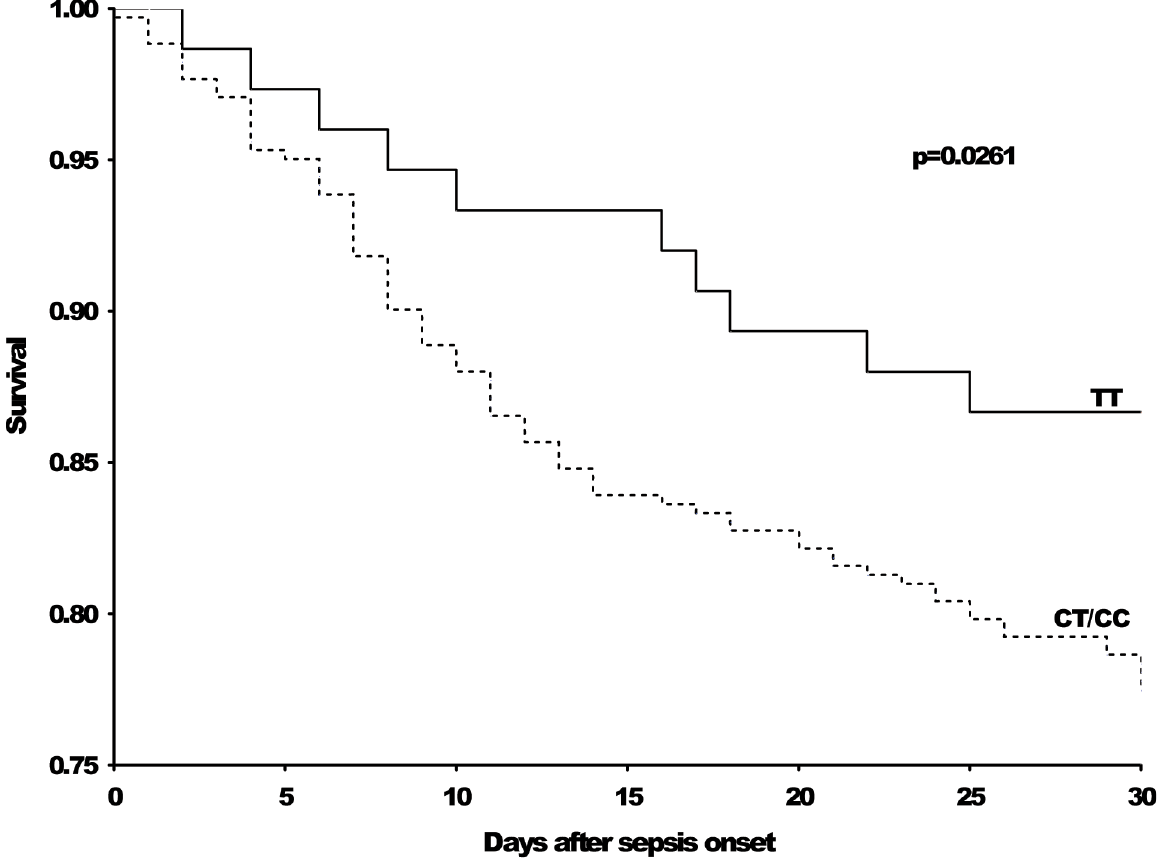
Fig 1. Kaplan-Meier survival analysis. The Kaplan-Meier curve shows the survival curves censored at day 30 for the CD14 rs2569190 TT and CT/CC genotypes. Within this patient sample, the mortality risk was higher among CT/CC patients than among patients with a TT genotype (p = 0.0261, Cox's F-